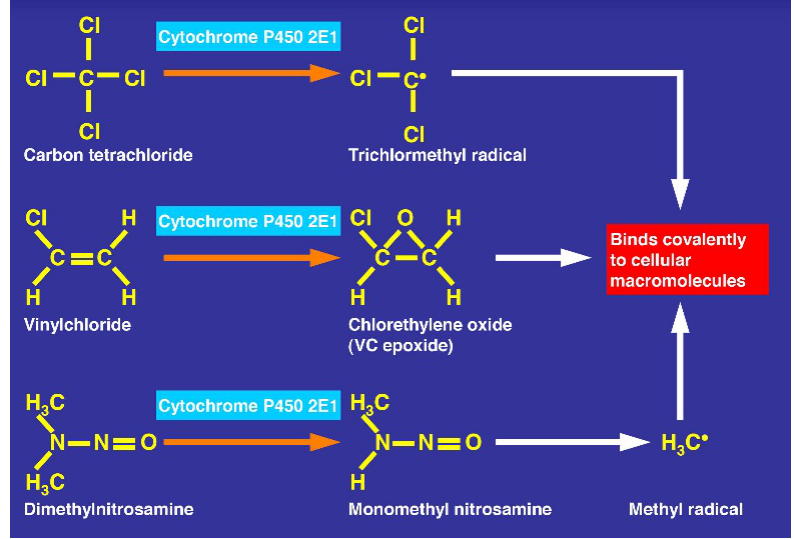
Figure 19. CCl 4 metabolized by cytochrome P450 2E1 similarly to other toxins such as vinyl chloride and dimethylnitrosamine.